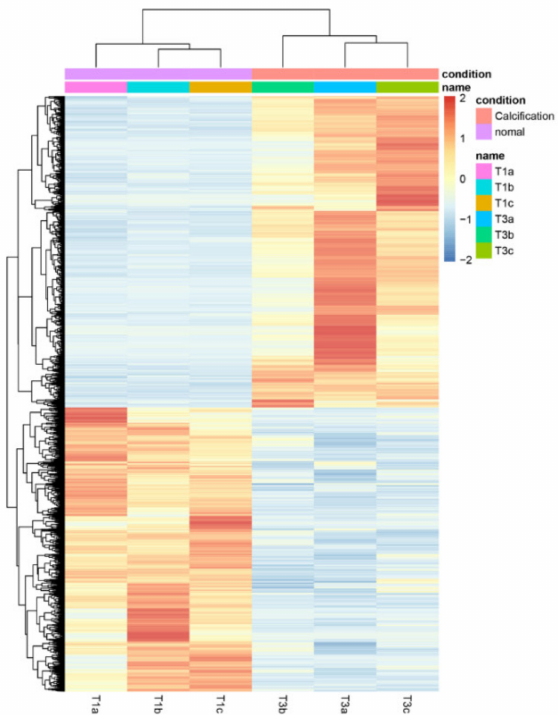
Figure 3. Heat maps of the differentially expressed genes (DEGs) in the 0% and 50% stages of chestnut calcification. The fragments per kb per million (FPKM) read values of unigenes were used for hierarchical cluster analysis. Expression levels are shown in different colors; the redder or bluer the color, the higher or lower the expression, respectively. The two groups, T1a, T1b, T1c and T3a, T3b, T3c, represent 0 % and 50% stages of chestnut calcification,